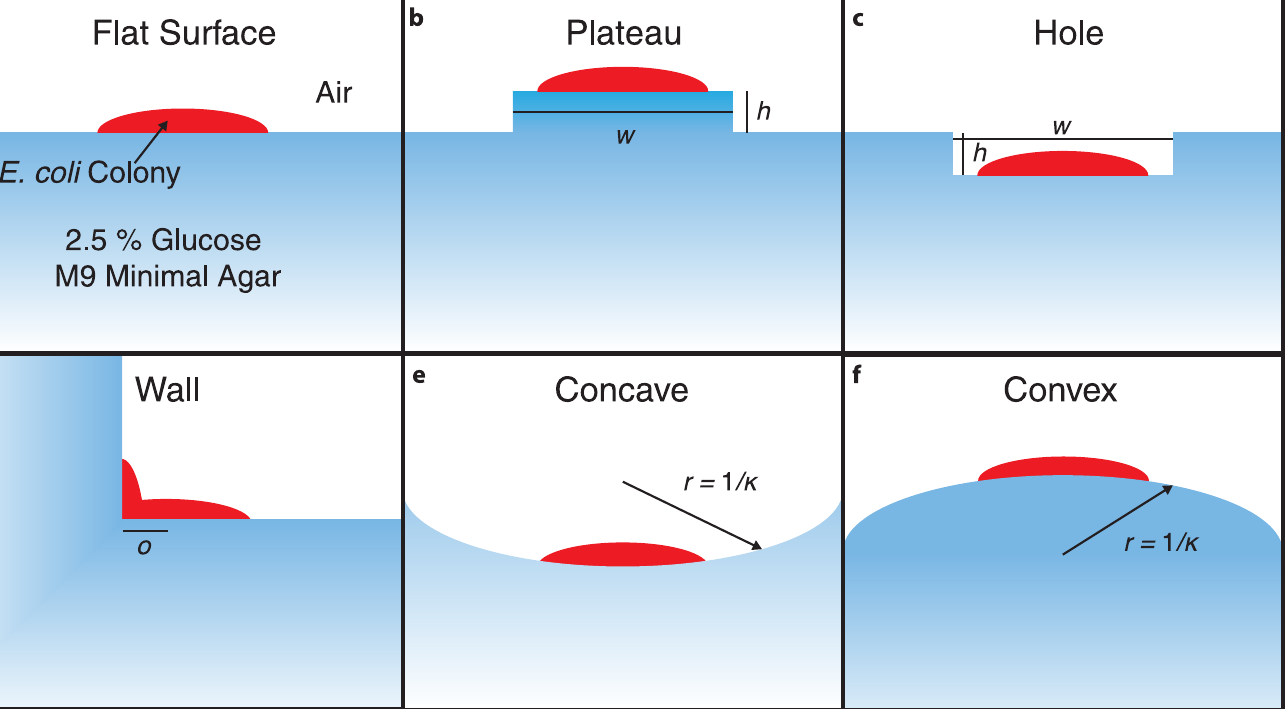
PLOS ONE | https://doi.org/10.1371/journal.pone.0182570 August 18,